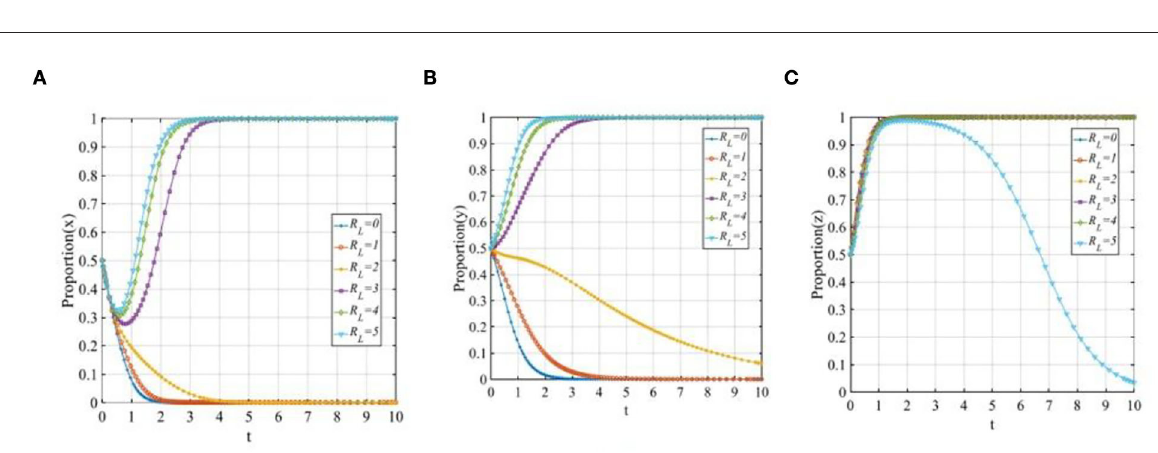
Figure 15. When the initiative cost of financial regulators